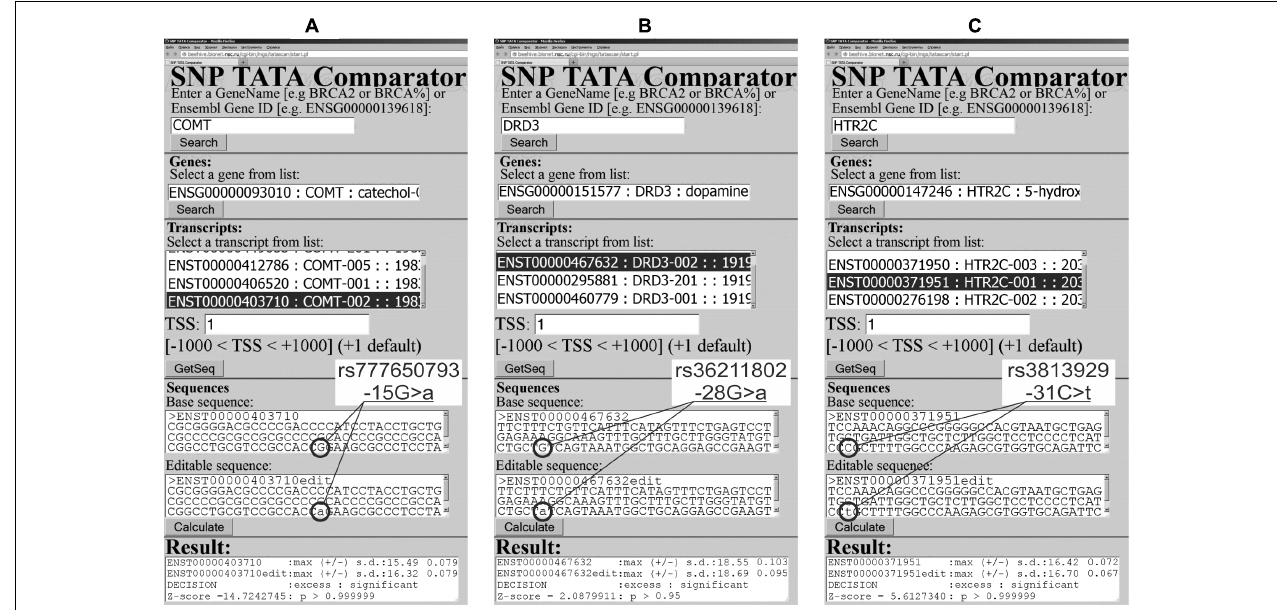
FIGURE 2 | Examples of our predictions in this work in the case of the human genes encoding neuropeptidergic-system-unrelated proteins. (A) rs777650793; (B) rs36211802; and (C) rs3813929.